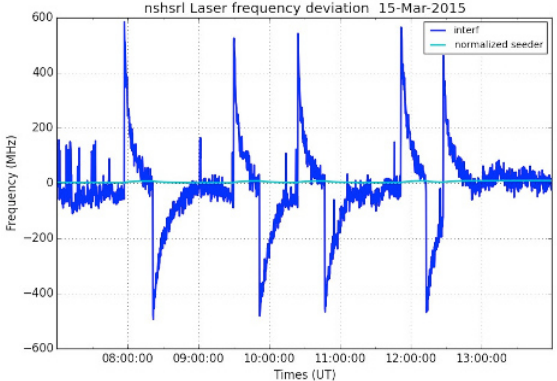
Figure 3: Slope estimate Iodine locking dealing with DPSS seed laser operating point jumps. (measured